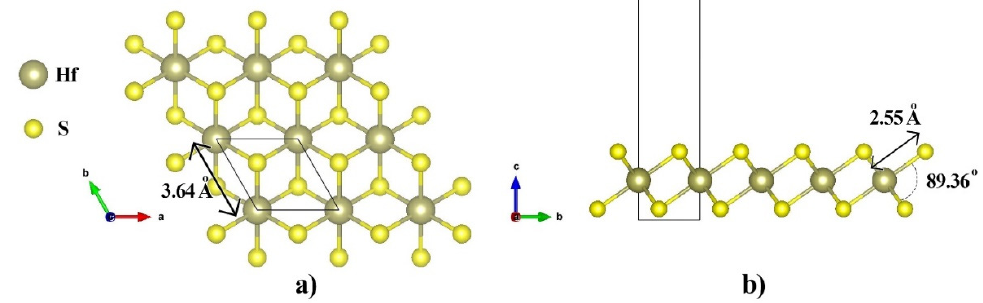
Figure 1. ( a ) Top view and ( b ) side view of the atomic structure of the hexagonal HfS 2 monolayer. The light brown and yellow balls represent Hf and S atoms, respectively. The black rectangle denotes the unit cell.